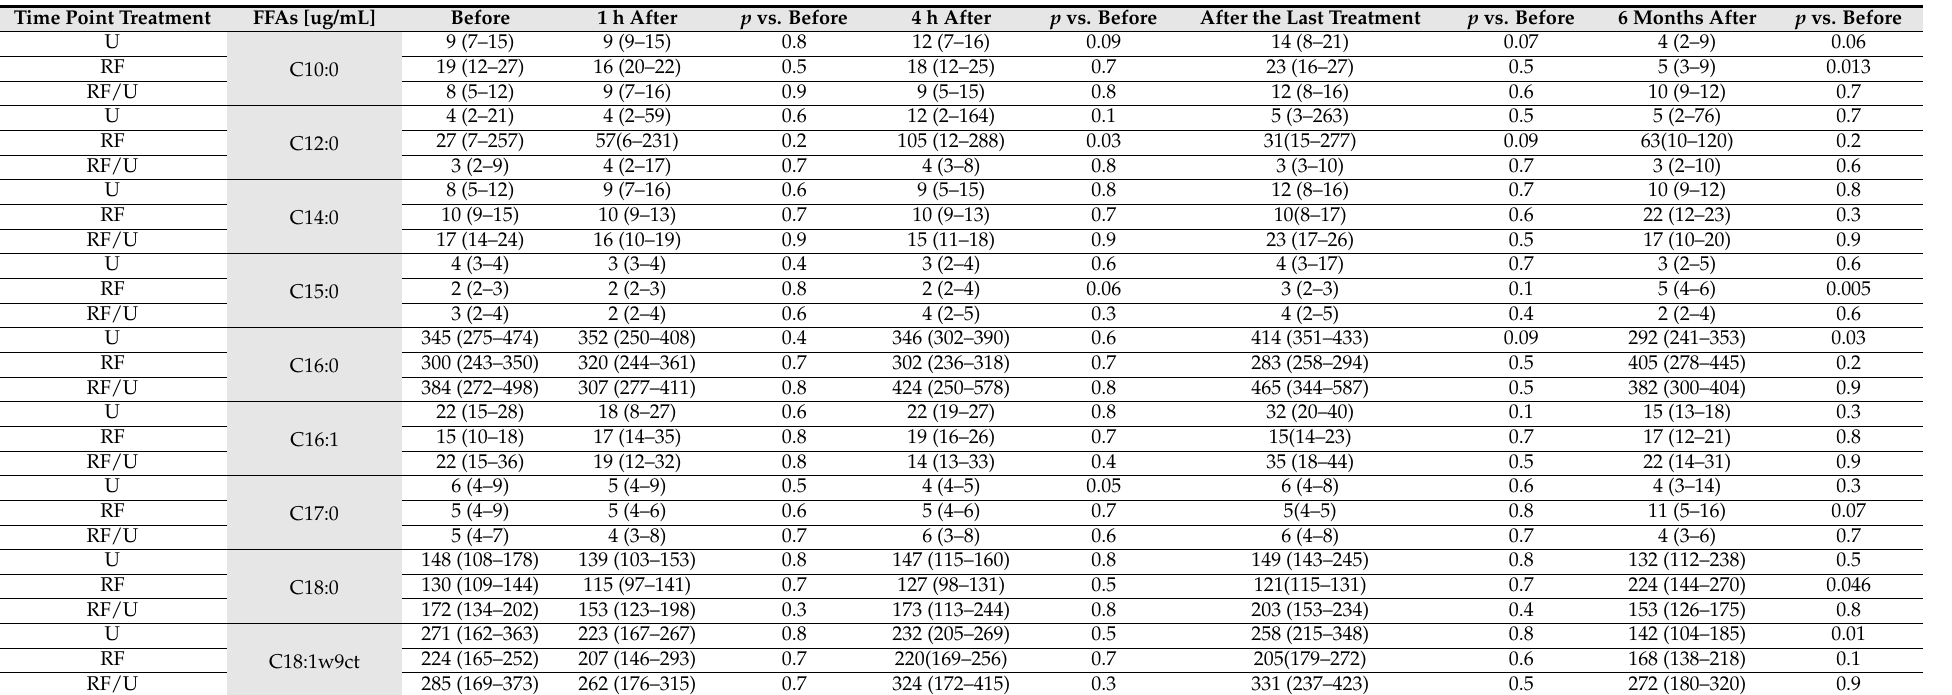
Table 6. Content of fatty acids in the blood